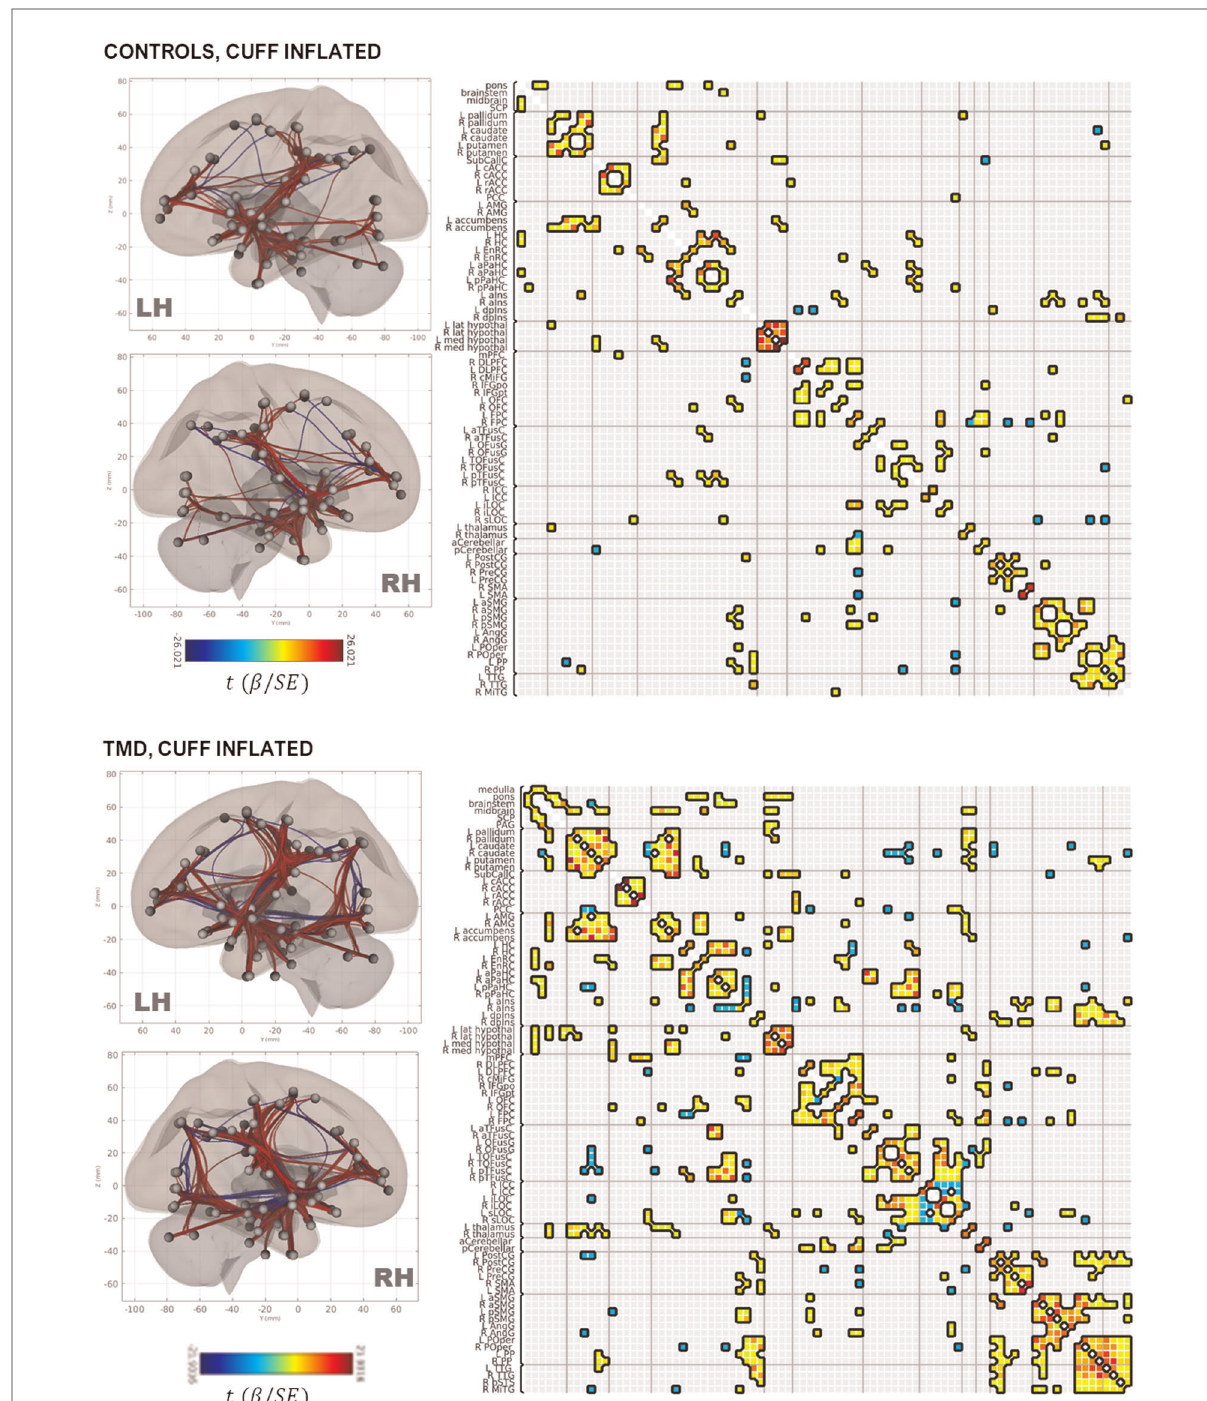
FIGURE 3 Rendering of functional connectivity networks and correlation matrices for connections surviving one-sample t -tests in control ( top panel ) and TMD participants ( bottom panel ) in the cuff-in fl ated condition. The color bar corresponds to the Wald t -statistic for each connection (the general linear model regression coef fi cient divided by its standard error). Negative, or blue, values represent negative or antiphase correlations between ROIs, whereas positive, or red values represent positive or in-phase correlations between ROIs. ROI abbreviations are de fi ned in Supplementary Table S1